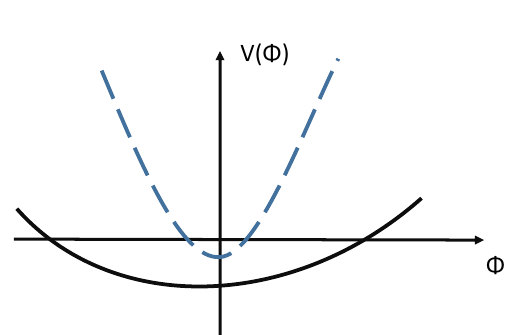
Fig. 1 The potential with the dashed line is better suited for uplifting than the potential with the solid